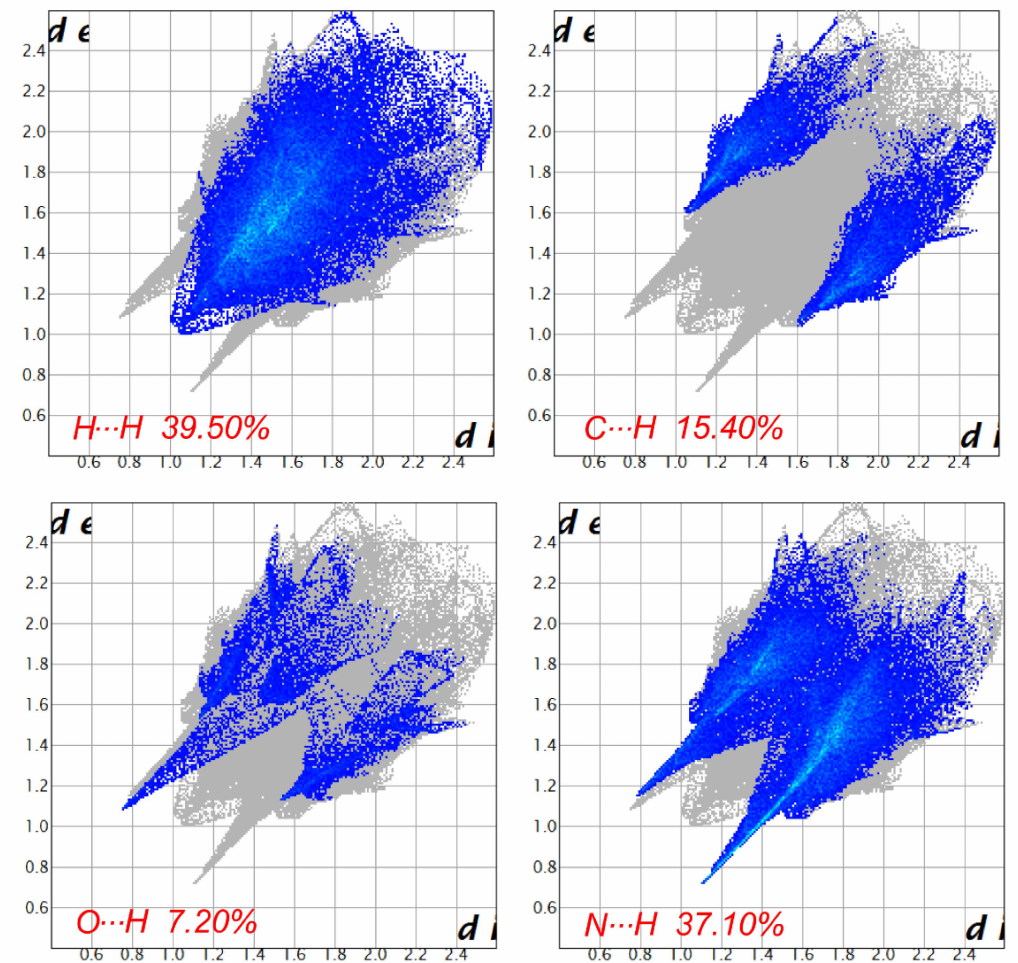
Figure 5. Two-dimensional fingerprint plots of the interatomic interactions of 1 displaying the percentages of the contacts that contributed to the total Hirshfeld surface area of the